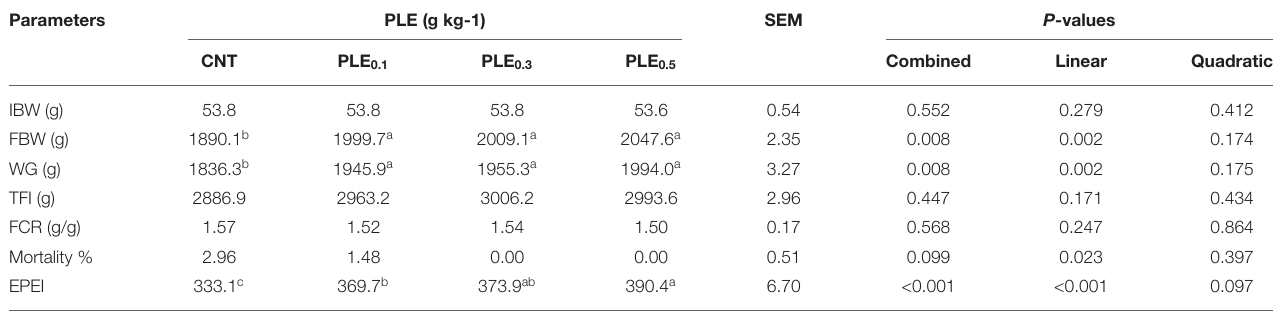
TABLE 5 | Productive performance parameters of broilers as affected by PLE supplemented diets at different levels. Parameters